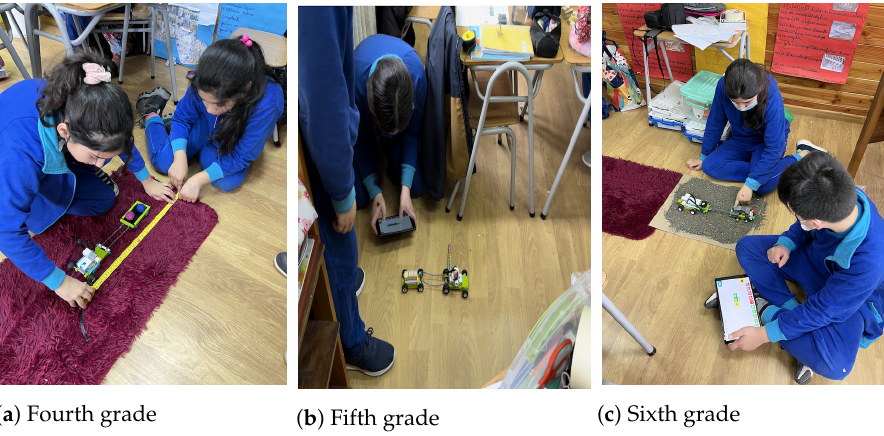
Figure 2. Fourth session exploration activities.